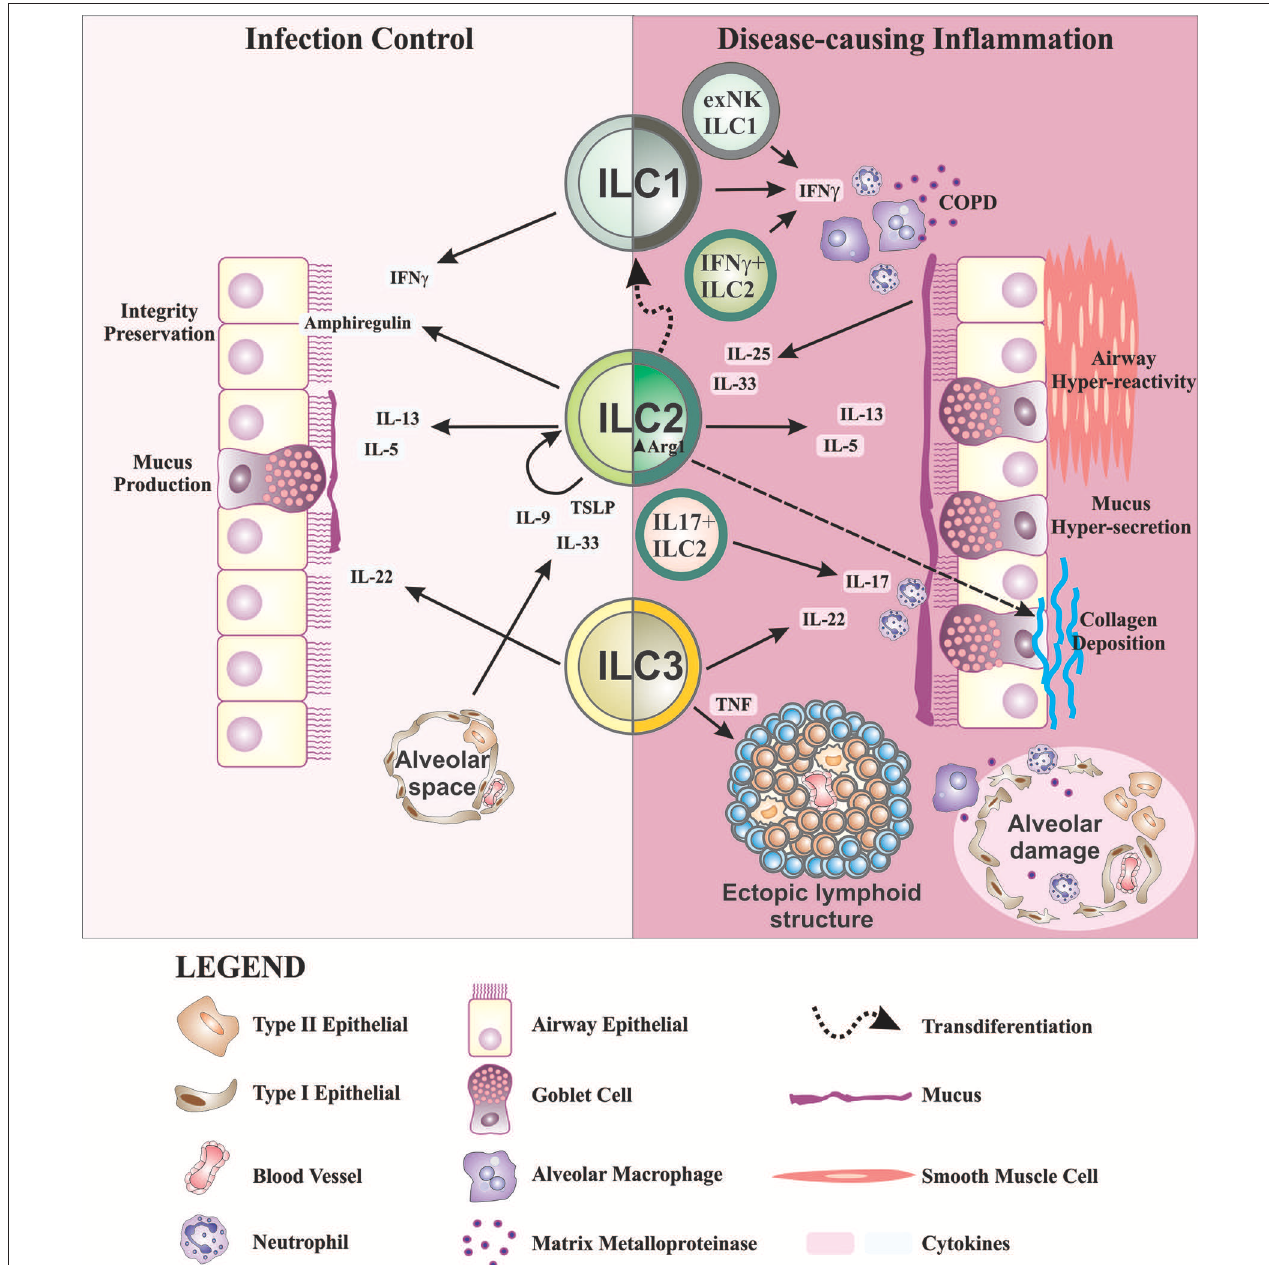
FIGURE 2 | Schematic representation of ILCs in lung health and disease. ILC2s are important for the preservation of airway barrier integrity during homeostasis. During inflammation in response to allergens, IL-33, and TSLP produced by alveolar type II epithelial cells are known to drive IL-9 production in ILC2s. Autocrine IL-9 promotes IL-5 and IL-13 production which drives mucus production from goblet cells in the airways. ILC2s also produce amphiregulin during infection to activate epithelial repair responses. IL-22, an important factor for the maintenance of epithelial barrier function, mucus production and tissue repair, is predominantly produced by ILC3s. In disease settings, IL-25 and IL-33 from airway epithelial cells induce IL-13 and IL-5 production from ILC2s which contribute to airway hyper-reactivity, mucus overproduction, and airway inflammation in asthma. Further dysregulation of ILC2s through increased expression of Arg1 promotes collagen synthesis and deposition causing lung fibrosis. In addition to the contribution of IFN- γ + from ILC1s in recruiting and activating alveolar macrophages in COPD, there is accumulation of IFN- γ + ILC2s. Similar alterations in ILC phenotype are seen in asthma with the production of IL-17, primarily produced by ILC3s, co-expressed with IL-13 by ILC2s causing neutrophilia in COPD and asthma. Airway remodeling, an important feature in asthma and COPD, may in part be supported by LTi-like ILC3s and their participation in the formation of ectopic lymphoid structures. The above findings demonstrate a highly complex interplay of ILCs, cytokines and other inflammatory mediators within the lung. The highly plastic nature of ILCs, which follow cues from the inflammatory milieu, causes them to become dysregulated during chronic lung disease due to an overt and persistent onslaught of inflammatory mediators.